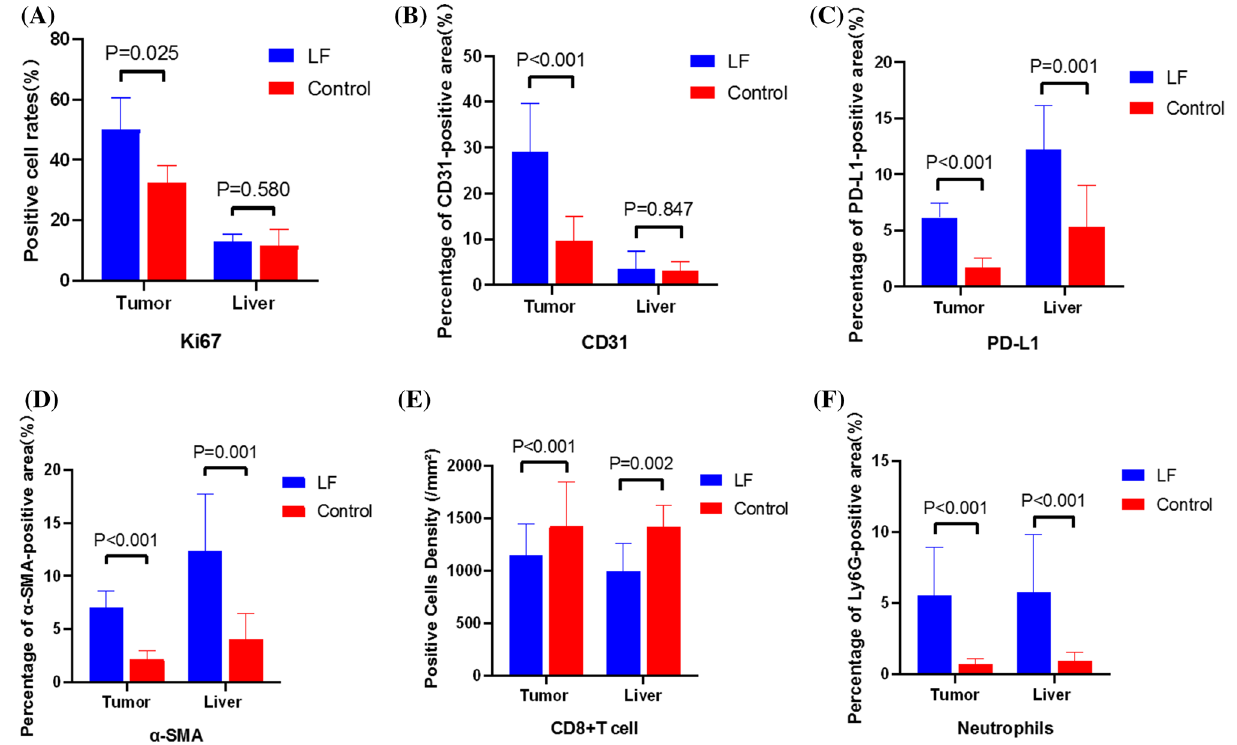
Figure 3. Quantitative analysis of immunohistochemistry results of Ki67, CD31, PD-L1, α-SMA, CD8 + T cell and Ly6G.